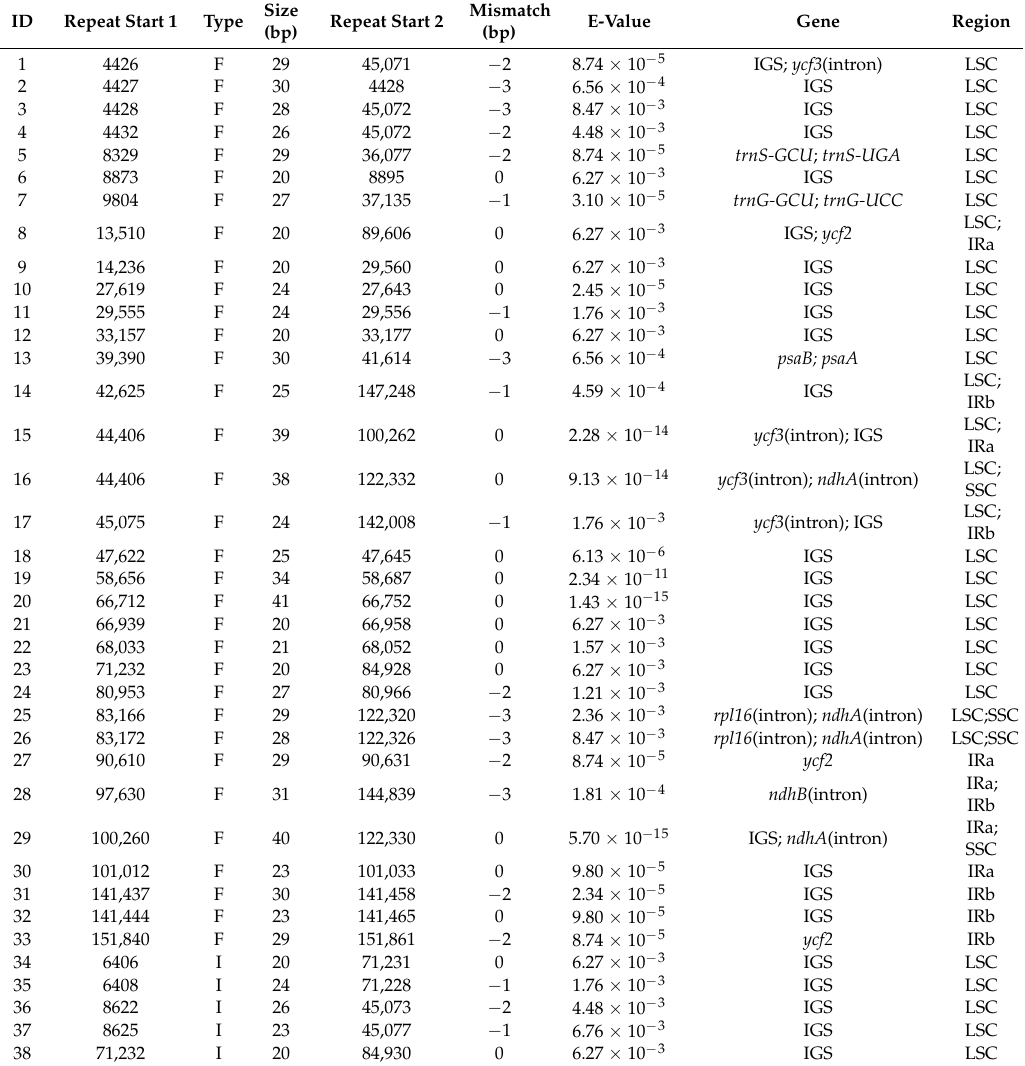
Table 3. Repeat sequences in the Rosa chinensis var. spontanea chloroplast